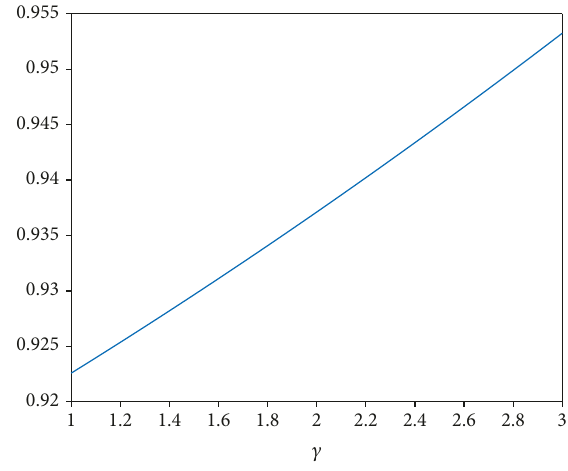
Figure 3: The impact of γ onto k ∗